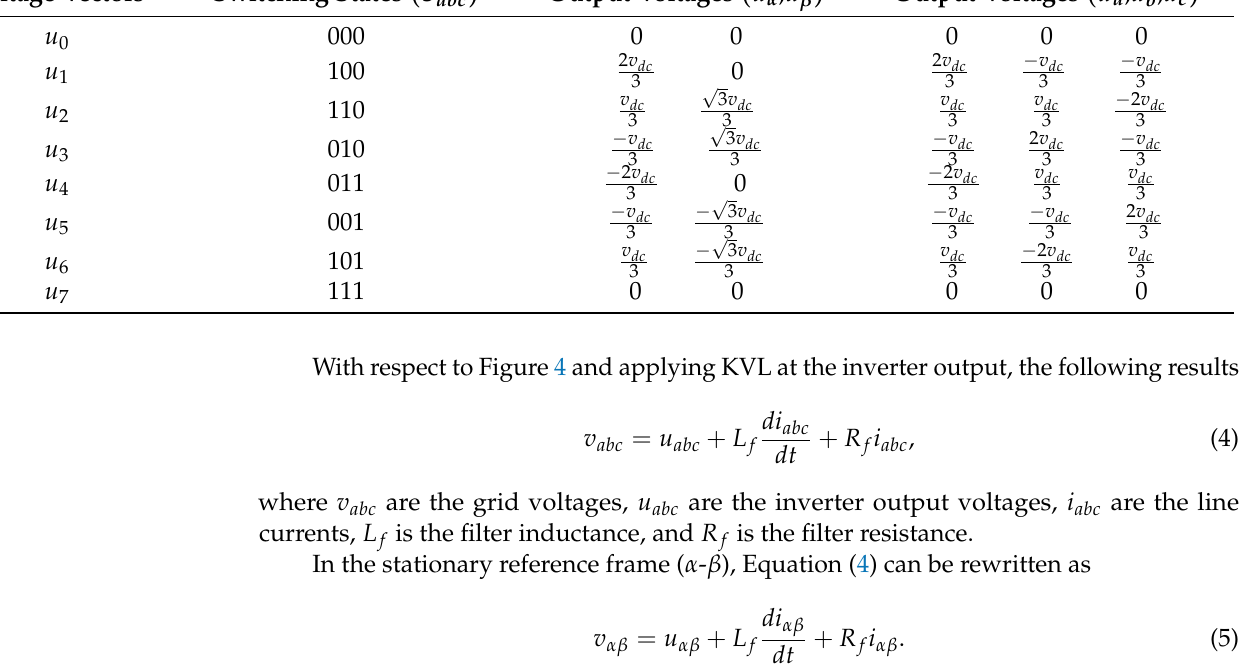
Figure 4. ( a ) Two-level voltage source inverter with grid connection. ( b ) Switching states and voltage vectors of the inverter. Table 1. Switching actions and output voltages of the two-level inverter in αβ and abc frames. Voltage